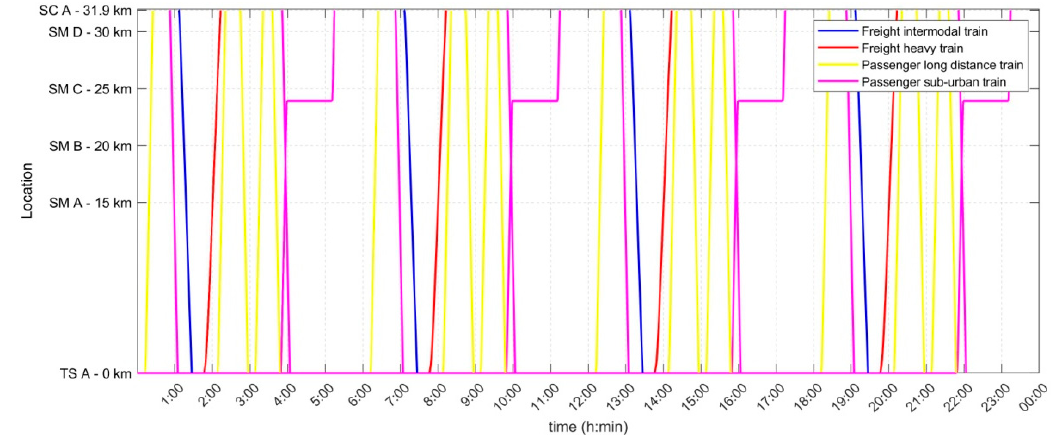
Figure 6. The graphic timetable of trains operation on an analyzed railway line .